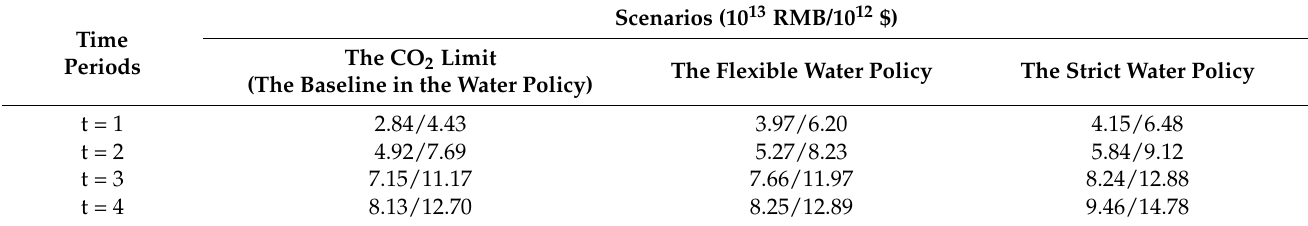
Table 8. The system cost under different environmental